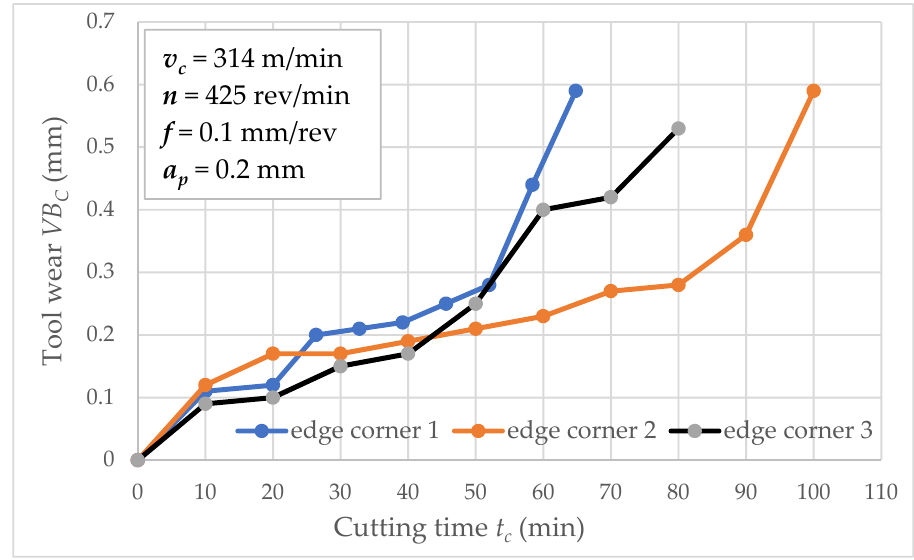
Figure 3. Tool wear VB C as a function of cutting time t c ( v c = 210 m/min).